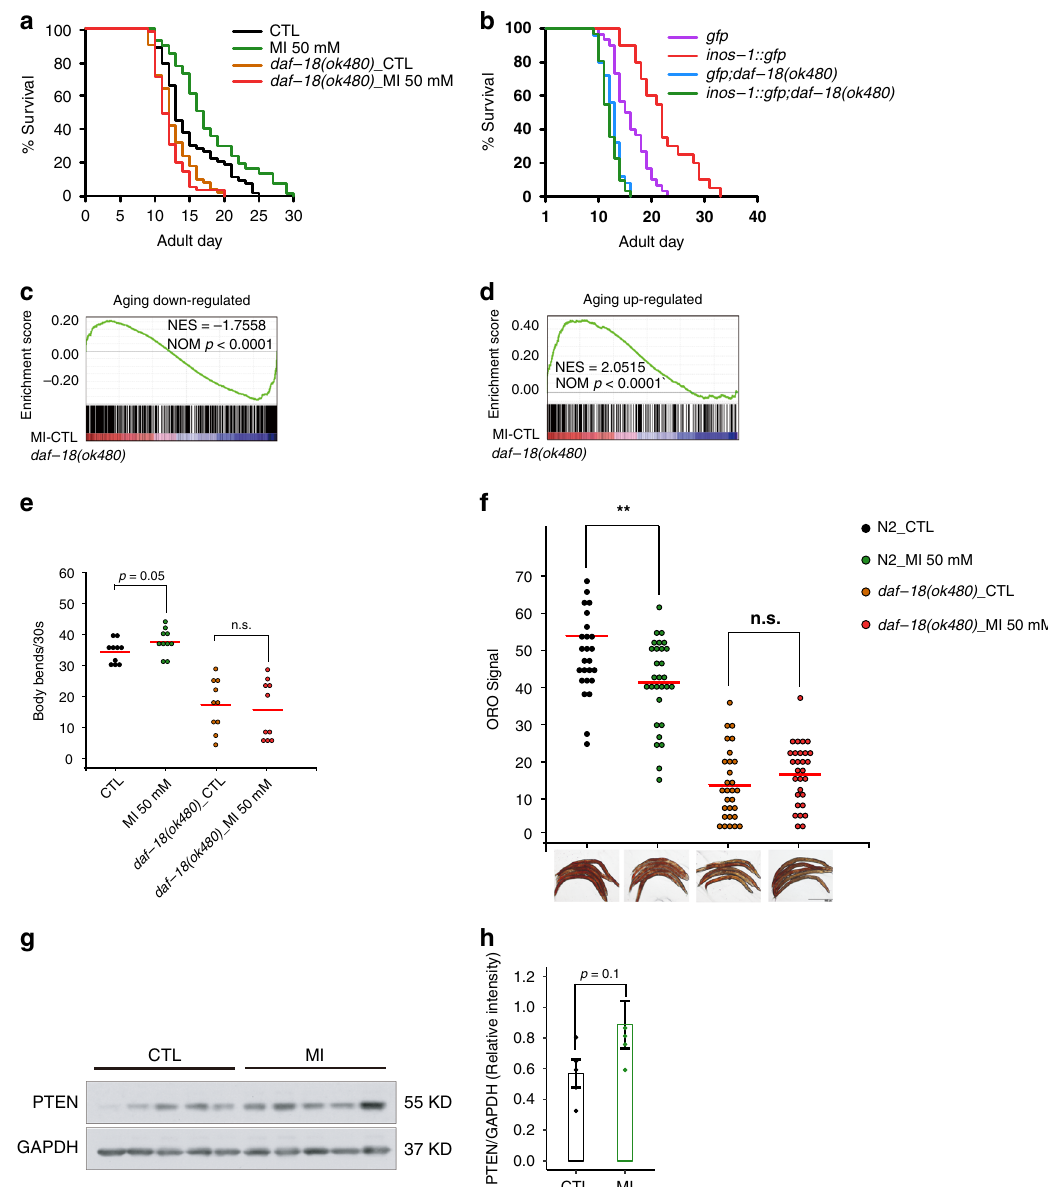
Fig. 5 The aging-alleviating effect of MI completely depends on DAF-18(PTEN). a daf-18 -NL [ daf-18(ok480) ] fully blocked the longevity effect of MI, N = 4. b daf-18 -NL fully blocked inos-1 OE longevity effect, N = 2. c , d MI supplementation could not reverse the aging-up or downregulated genes expression changes in daf-18 -NL worms (GSEA p < 0.0001 for both), N = 1. e MI could not increase the mobility of old (AD_8) daf-18 -NL worms as in control N2 worms ( n = 10 for each group, two-sided t -test n.s. not signi fi cant), N = 2. f MI could not inhibit the fat storage in old (AD_8) daf-18 -NL worms as in control N2 worms ( n = 30 in each group, two-sided t -test n.s. not signi fi cant), N = 3. g MI supplementation upregulated the PTEN protein level in mouse muscle, N = 3. h Quanti fi cation of the immunoblotting result (two-sided t -test p = 0.1). Source data are provided as a Source Data fi to promote healthy human aging (Fig. 4a; Supplementary For RNAi constructs, RNAi sequences were designed using an online tool, https:// www.dkfz.de/signaling/e-rnai3/, the fragments were inserted into L4440 vector, Figs. 1a, b, 5). between Spe I and Xho I sites. Other RNAi strains are from another library 54 . Methods Worm strains and constructs . Worm strains are listed in Supplementary Table 1. Primers are listed in Supplementary Table 2. Worms were cultured at 20 °C on nematode growth medium (NGM), which were freshly made or air-tightly stored at 4°C before use. To create Psir5::inos-1::GFP::let858.3-3 ’ UTR construct, a fragment from inos-1 start to the last amino acid codon was cloned between NotI and XbaI sites of the vector pPD158.87. The empty vector was used as control. Plasmids were injected to young adult worm gonad line to get transgenic worms, without genome integration. Transgenic worms were maintained by picking under fl uorescent microscopy.